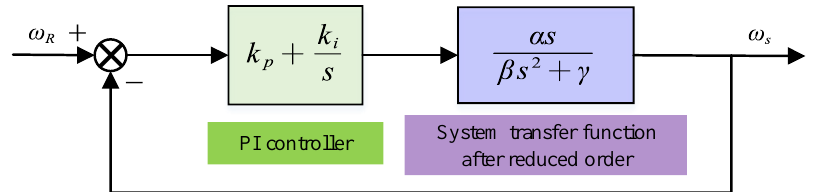
Figure 2. PI control double flexible body system block